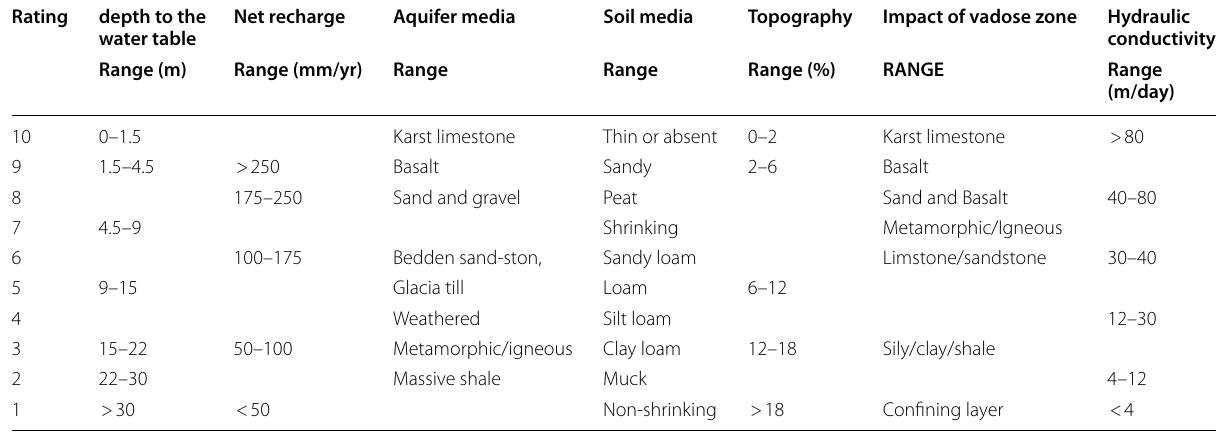
Table 3 The relative weights and rates of DRASTIC parameters (Aller 1985) and (Secunda et al. 1998) for various hydro-geological